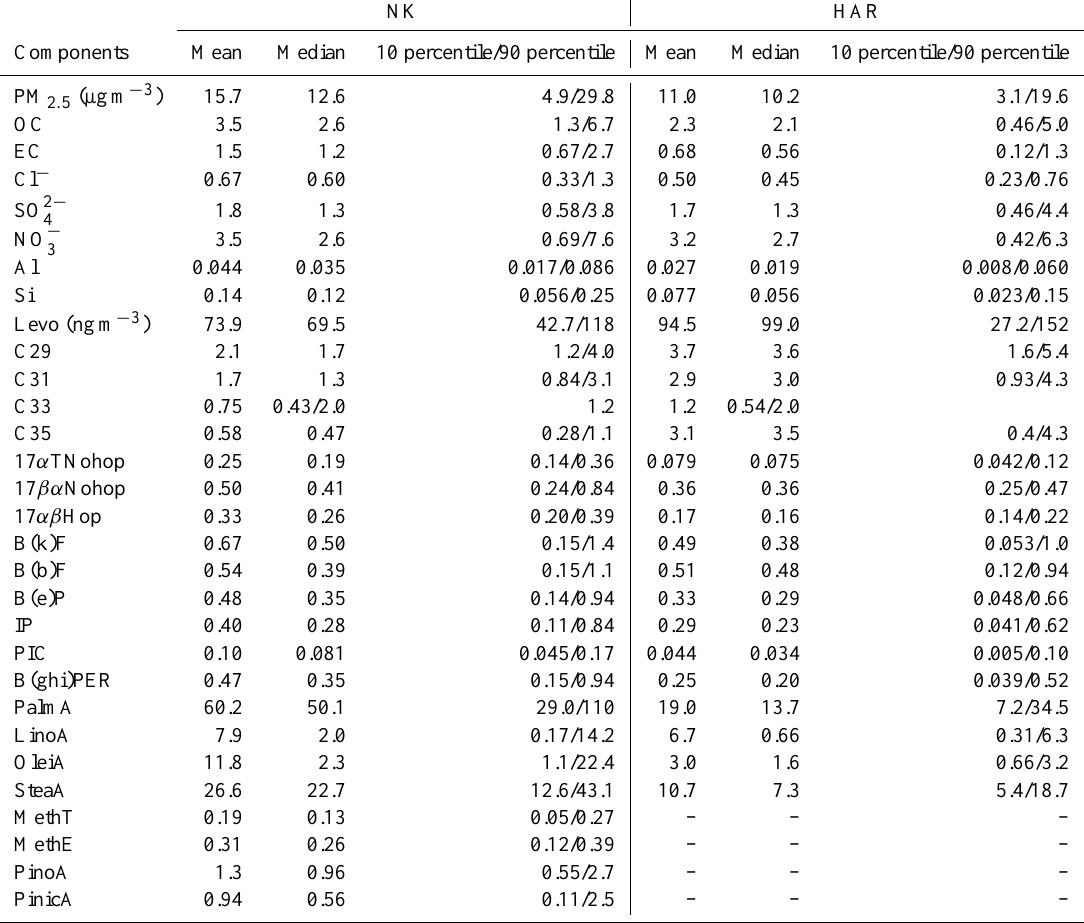
Table 2. Concentration summary of measured components at NK and